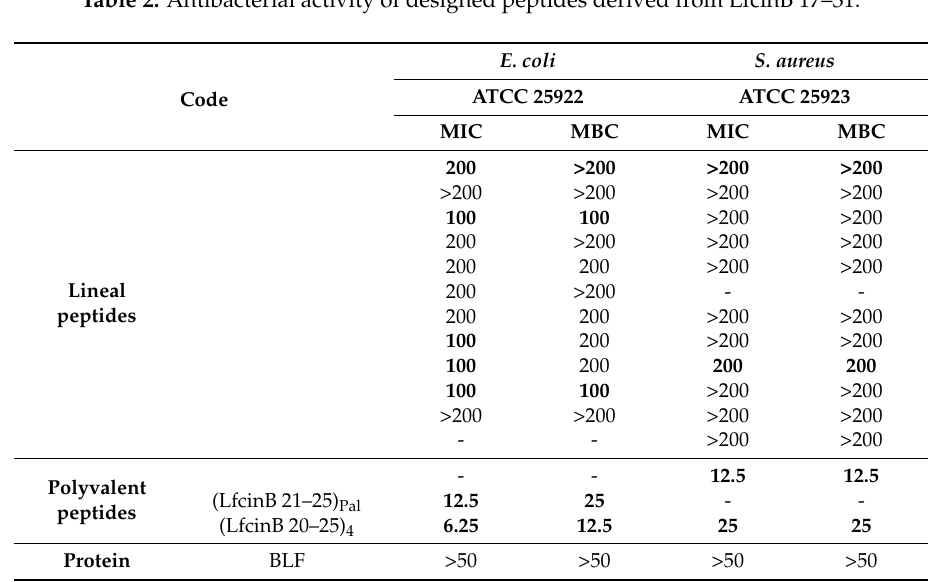
Table 2. Antibacterial activity of designed peptides derived from LfcinB 17–31.